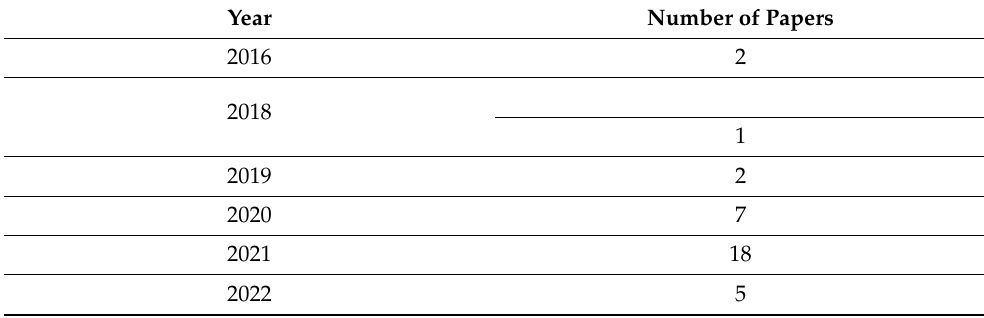
Table 3. Distribution of selected papers publication